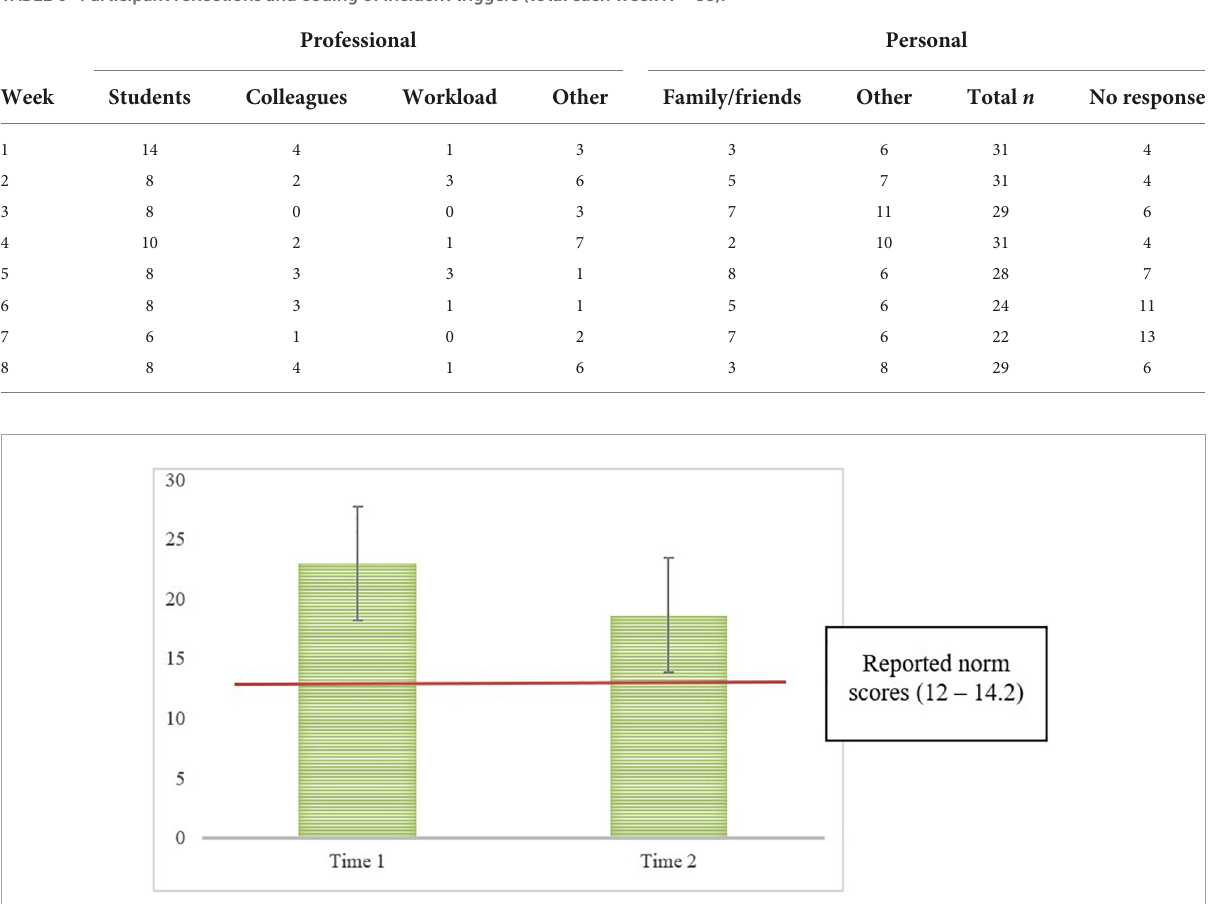
TABLE 6 Participant reflections and coding of incident triggers (total each week N = 35).